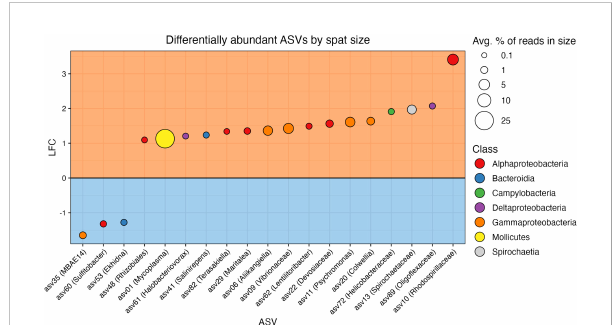
FIGURE 5 Results from ANCOM-BC2 showing differentially abundant ASVs in each size class. ASVs are colored by taxonomic class. The orange box (top) includes ASVs differentially abundant in the large spat, and the blue box (bottom) includes ASVs differentially abundant in the small spat. Vertical axis shows log fold change (LFC), the magnitude of differential abundance in large spat over small (Lin and Peddada, 2020). The size of points corresponds to the relative abundance of the ASV in the size class in which it is differentially